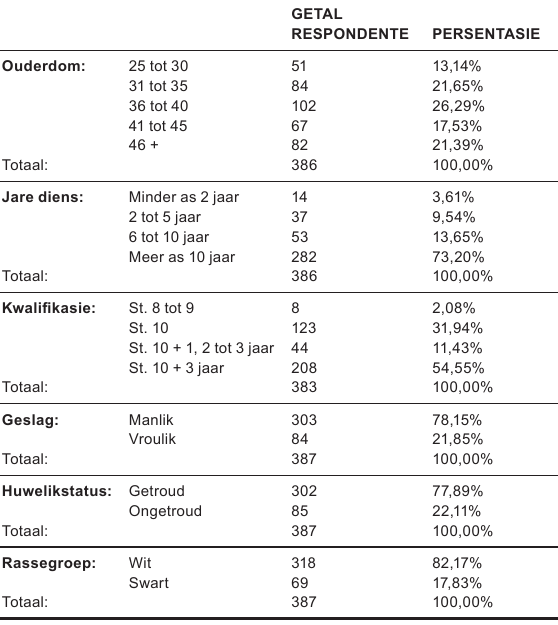
tabel 1 Biografiese besonderhede van